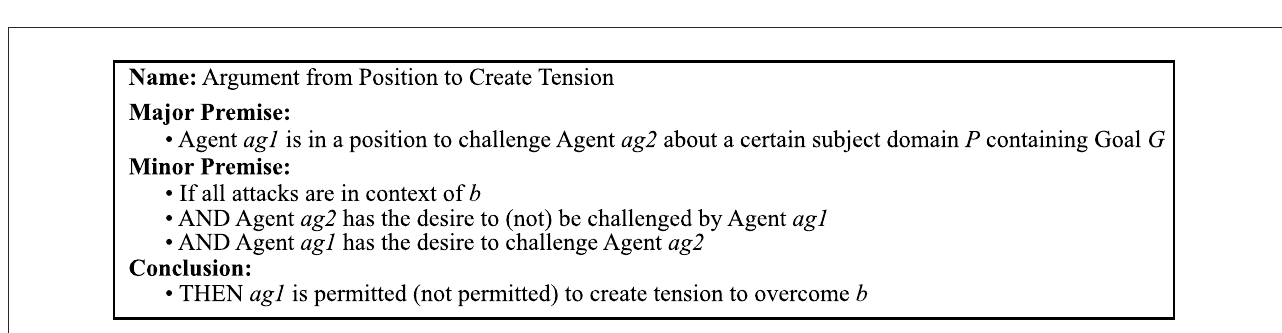
FIGURE7 Argument from Position to Create